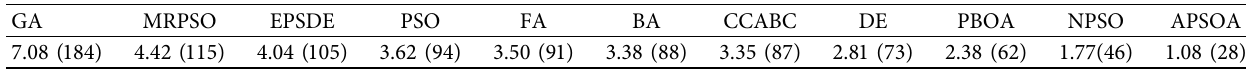
Table 3: Summary of the results presented in Table 2 (average rank of each method on all functions of the CEC 2009 benchmark). GA